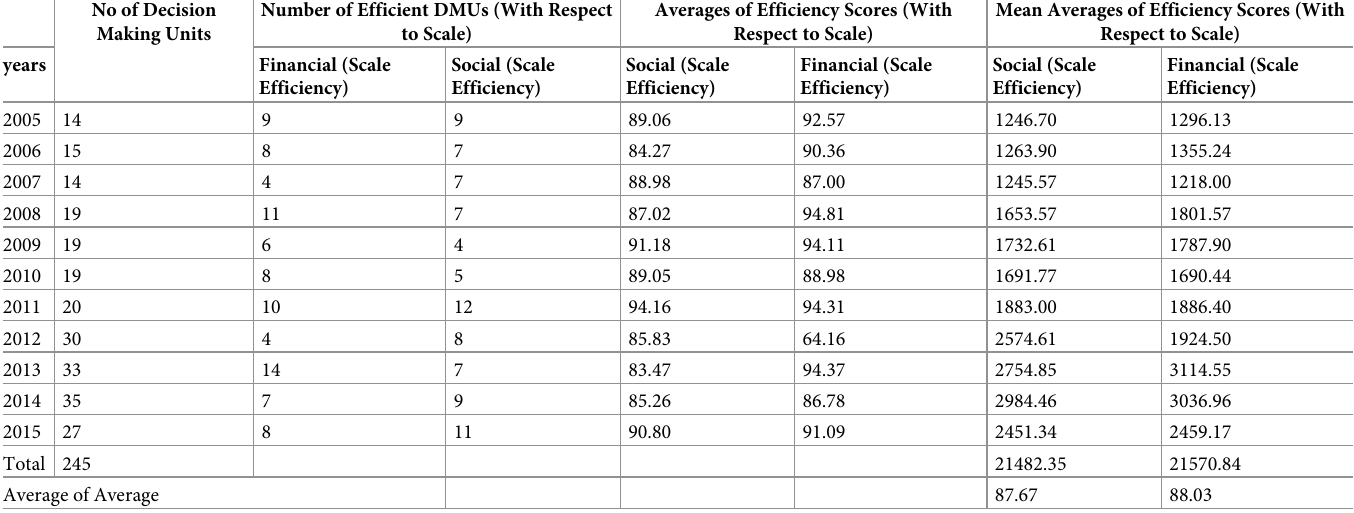
Table 4. Scale efficiency of partner organizations under the Pakistan Poverty Alleviation Fund (PPAF) with respect to the operational scale. No of Decision Making Units